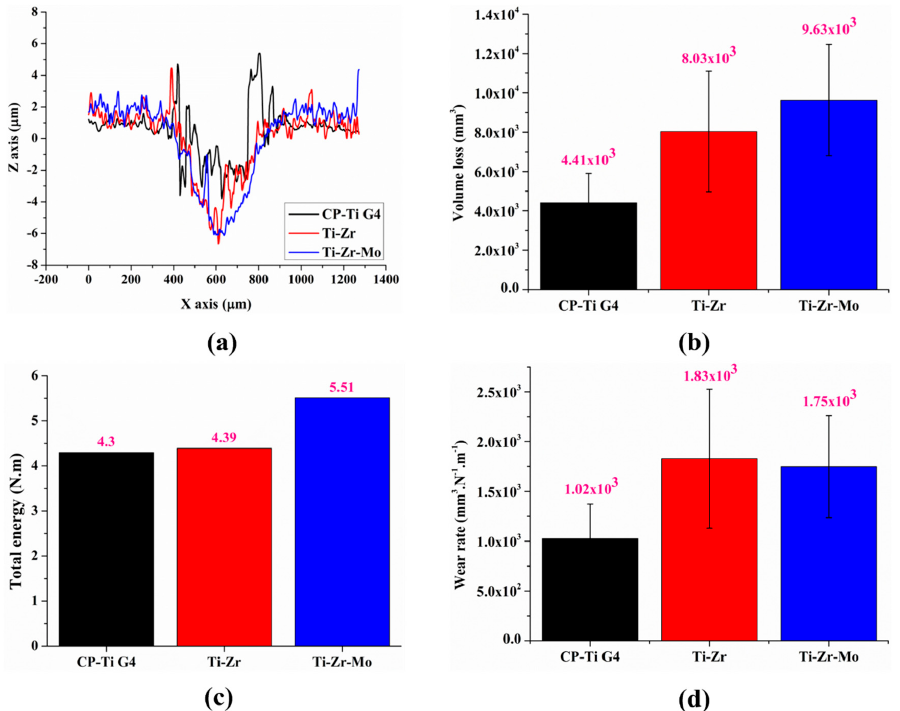
Figure 10. ( a ) profiles in X and Z axes. ( b ) bar plots of volume loss. ( c ) bar plots of total energy. ( d ) bar plots of wear rate. Therefore, the hardness, OCP, COF, wear track, and volume loss values of both de ‐ veloped samples were studied and compared in tribocorrosion with the well ‐ known ex ‐ cellent properties of pure titanium. The values are approximated and sometimes overlap with CP–Ti G4 behavior. 4. Conclusions To wrap up, the following conclusions were drawn for the investigated alloys: Corrosion tests revealed that adding Zr to Ti enhanced corrosion behavior by boost ‐ ing potential corrosion values. Adding Mo to this binary alloy improved corrosion behav ‐ ior even further. Moreover, the Ti–Zr–Mo alloy showed the lowest corrosion current den ‐ sity value. As a result, it demonstrated better corrosion behavior than the other alloys under investigation. Furthermore, the Ti–Zr–Mo sample had a significantly greater mag ‐ nitude arch and less capacitive behavior, indicating superior electrochemical perfor ‐ mance. Despite having the highest coefficient of friction and volume loss of the investigated samples, the Ti–Zr–Mo alloy required more energy to remove the material during tri ‐ bocorrosion, due to its high hardness. As a result, Ti–Zr–Mo had a marginally more sig ‐ nificant wear rate than Ti–Zr. Furthermore, the ternary alloy had a narrower track visible in the confocal microscope images, indicating that it has the intense recovery capability of the natural oxide layer throughout the experiments based on the open circuit potential, which contributes to the outstanding tribocorrosion behavior. Due to those factors, it was assumed that these newly developed biomaterials would exhibit superb behaviors by closely resembling the excellent qualities of pure titanium or